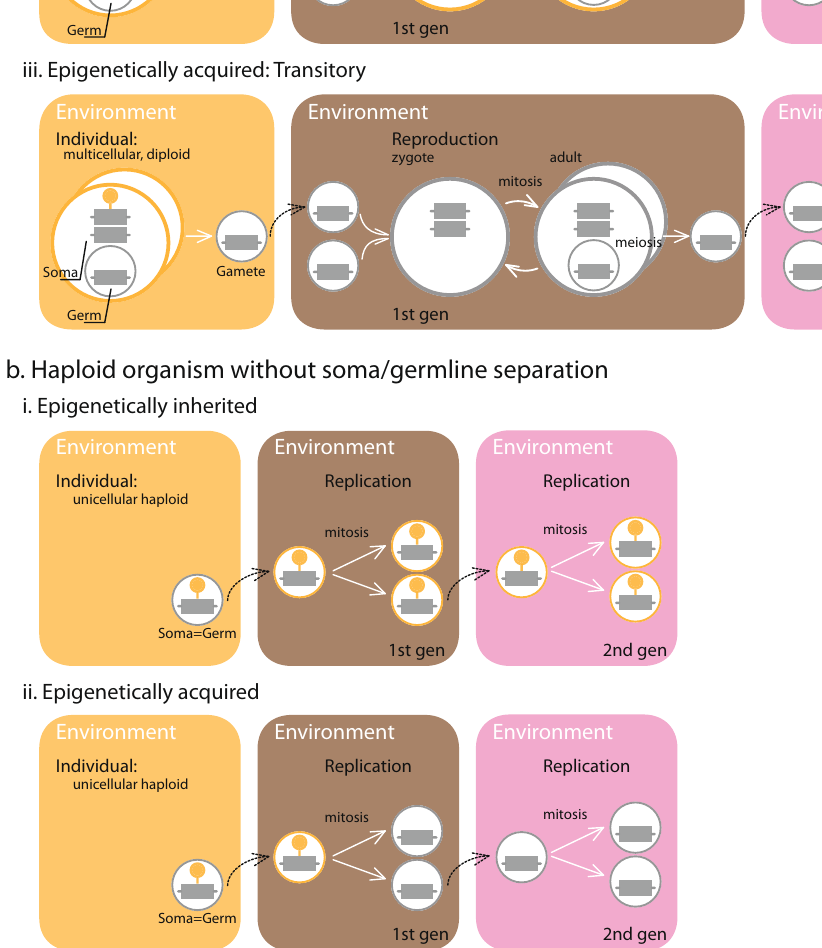
Fig. 1 Schematic representation of the different types of epigenetic marks observed in different organisms. Panel a refer to complex organisms, that is diploid with germline-soma differentiation. Each sub-panel depicts a different type of epigenetic mark a.i trans-generational epigenetically inherited, a.ii inter-generational epigenetically inherited, and a.iii epigenetically acquired. Panel b refer to complex organisms that are haploid with no germline-soma differentiation. Sub-panel b.i depicts epigenetically inherited marks, while b.ii depicts epigenetically acquired